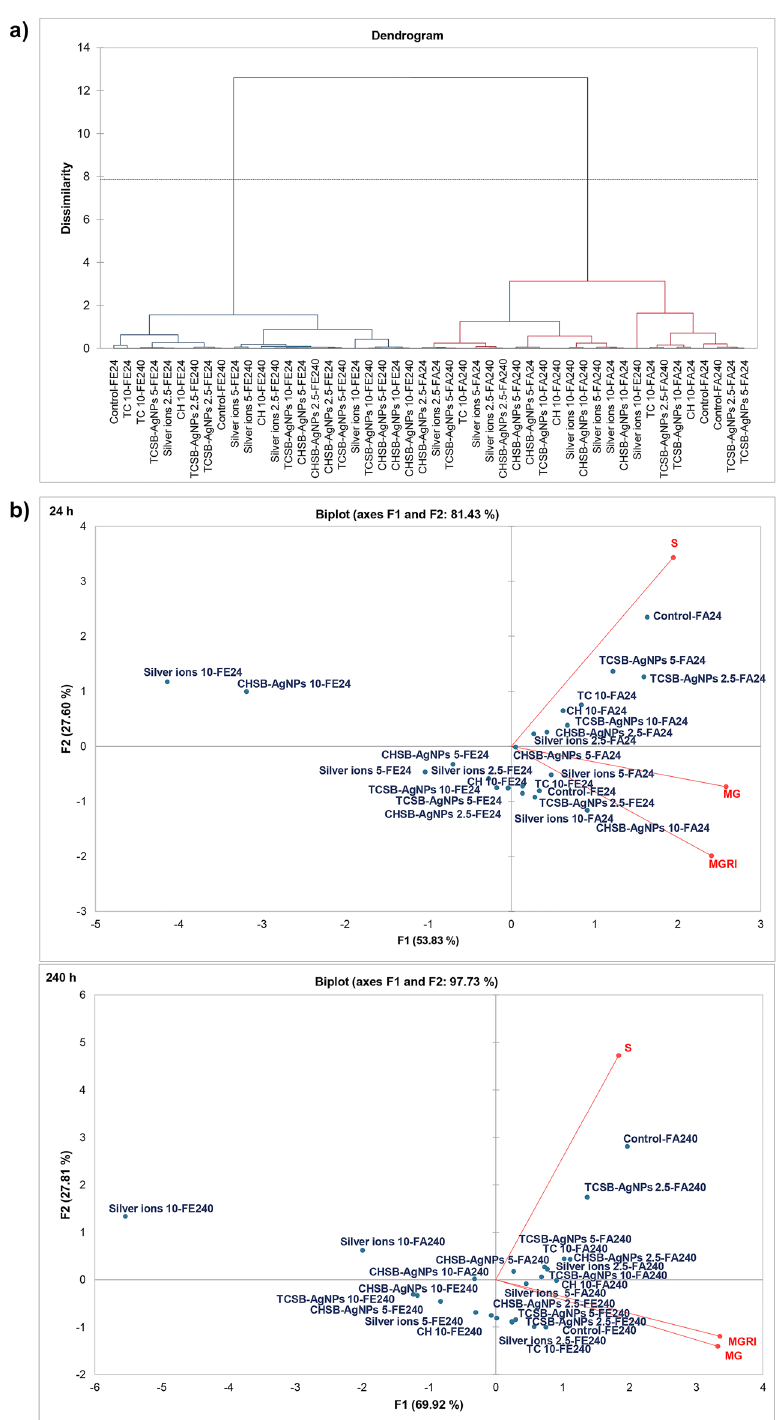
Figure 8. Interaction between silver ions, AgNPs and stabilizing agents, and fungi parameters over 24 h and 240 h on the basis of agglomerative hierarchical clustering ( a ) and principal component analysis ( b ). FA, F. avenaceum ; FE, F. equiseti ; S, sporulation; MG, mycelial growth; MGRI, mycelium growth rate index. The number given for each treatment represents the concentration expressed in mg L −1